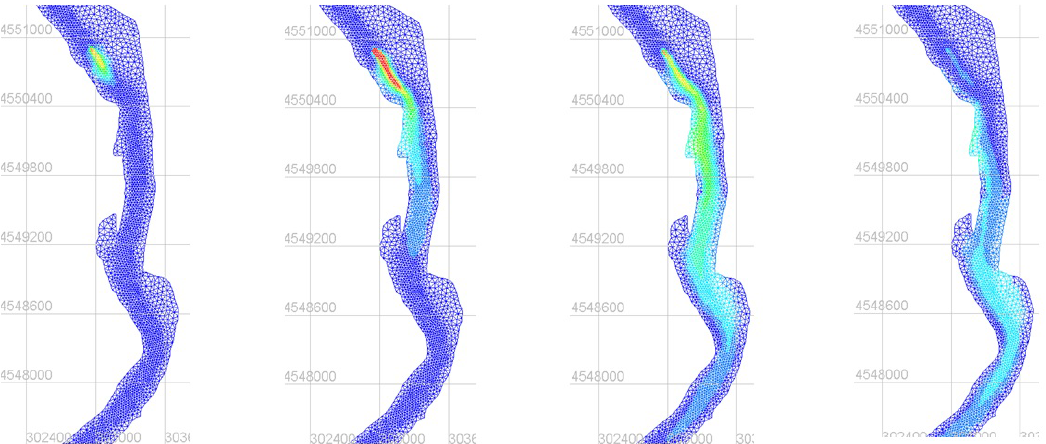
Figure 5. 2-dimensional simulation of the time evolution (from left to right) of the suspended sediment plume generated by a controlled injection at Mora d’Ebre (see Fig. 1) in the final reach of the Ebro River; permanent flow conditions of 100m 3 s − 1 and a triangular sedimen- tograph for the load with maximum value of 50mgL − 1